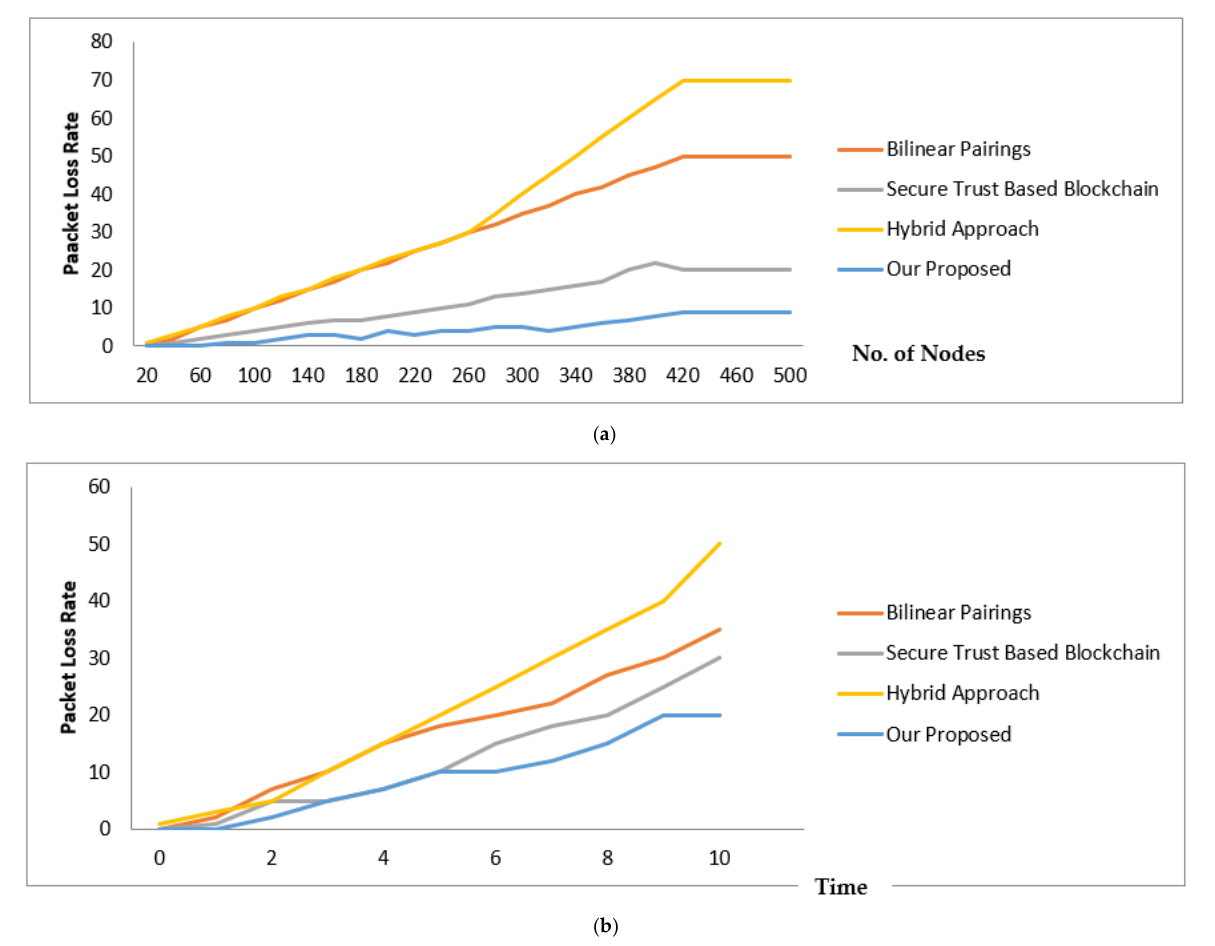
Figure 6. ( a ): Average Packet Loss Rate with DDoS Attack w.r.t No. of Nodes; ( b ): Average Packet Loss Rate with DDoS Attack w.r.t Time.